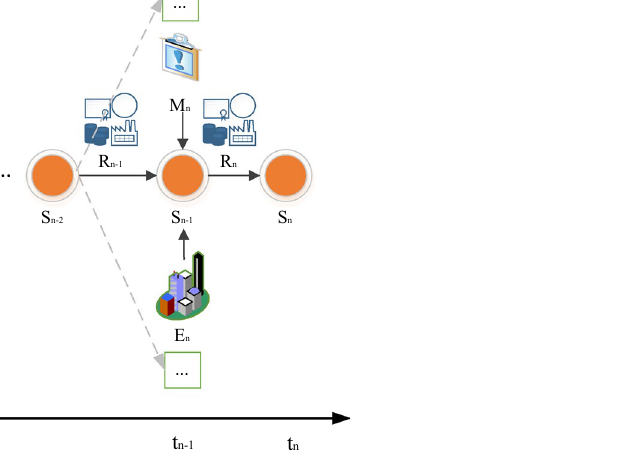
Figure 1. The evolution process of the emergency